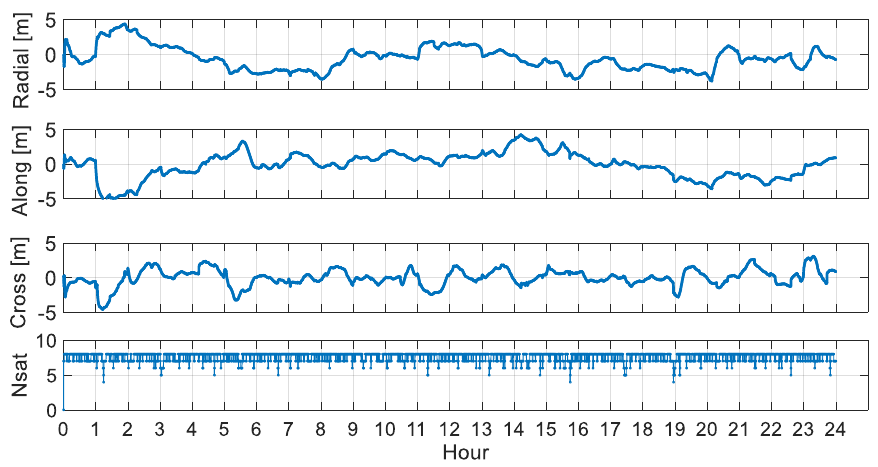
Figure 5. Swarm-A real-time POD results of Scheme 1. Table 4. Statistical results of Swarm-A orbit solutions on a normal day from different schemes (unit: m). Scheme